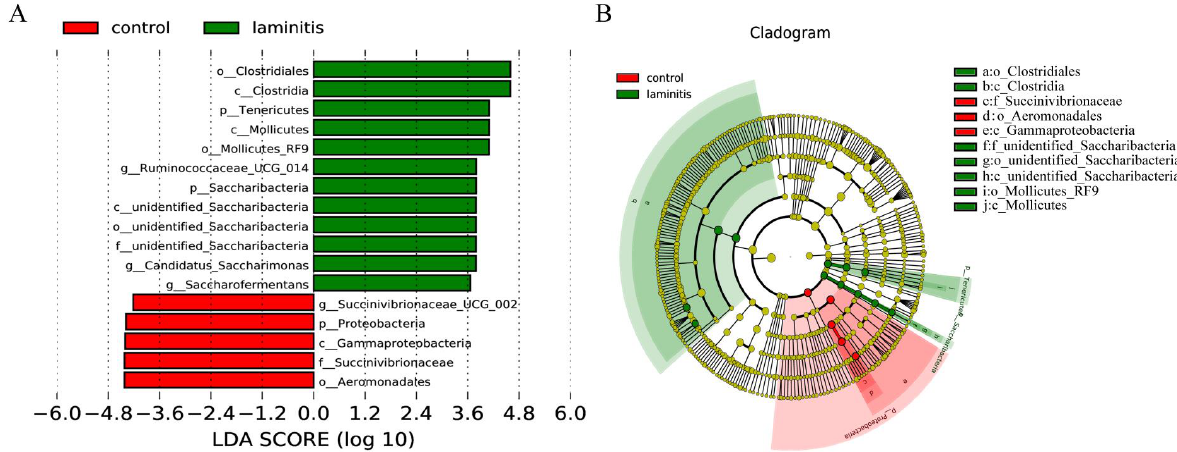
Figure 6. Taxonomic biomarkers: ( A ) LEfSe analysis between the control (red) and laminitis (green) groups. Ru- minococcaceae UCG 014 , Candidatus Saccharimonas , and Saccharofermentans genera were enriched in laminitis cows, while Succinivibrionaceae_UCG-002 genus was enriched in control group cows. ( B ) Cardiogram showing differentially abundant taxonomic clades with an LDA score > 3.5 among laminitis and control groups, p <